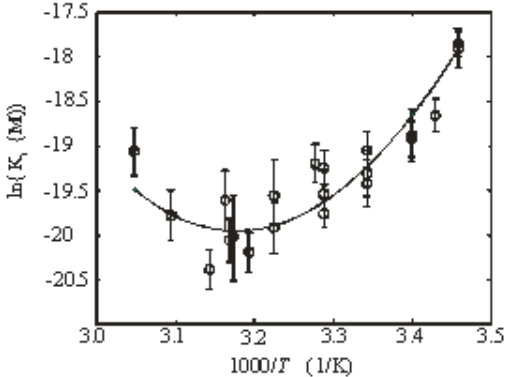
. A standard 2-state thermodynamic 3